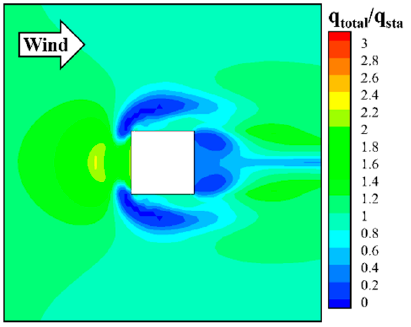
Figure 9. Normalized snow depth of the numerical simulation.